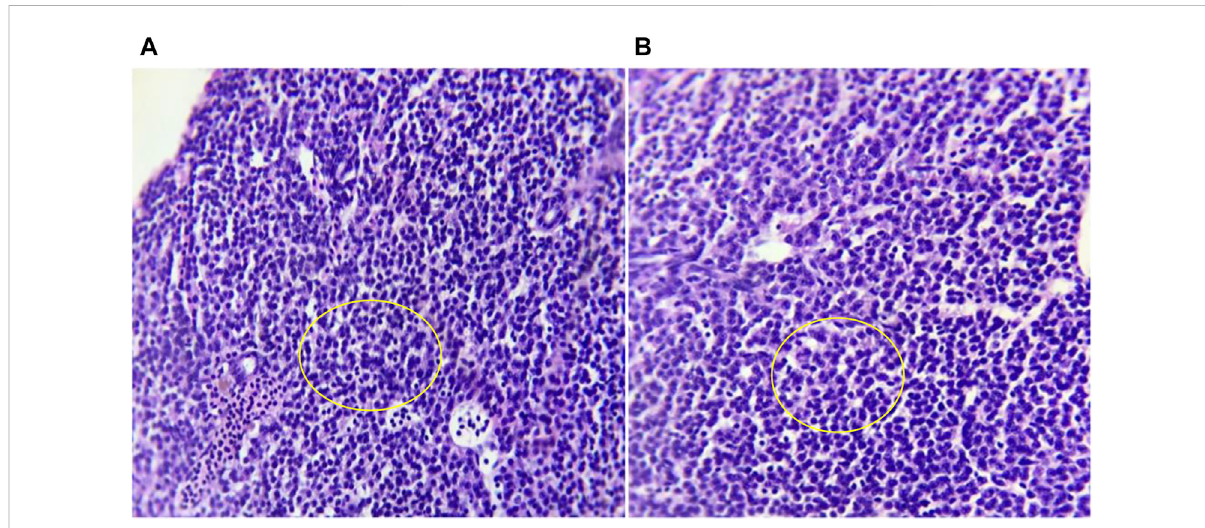
FIGURE 2 Photomicrographs at10X magni fi cation of haematoxylin and eosin (H&E) stained Liver histology of (A) control and (B) MCFE-treated zebra fi sh. In liver histology both groups shows well-organized polygonal shaped hepatic parenchyma.